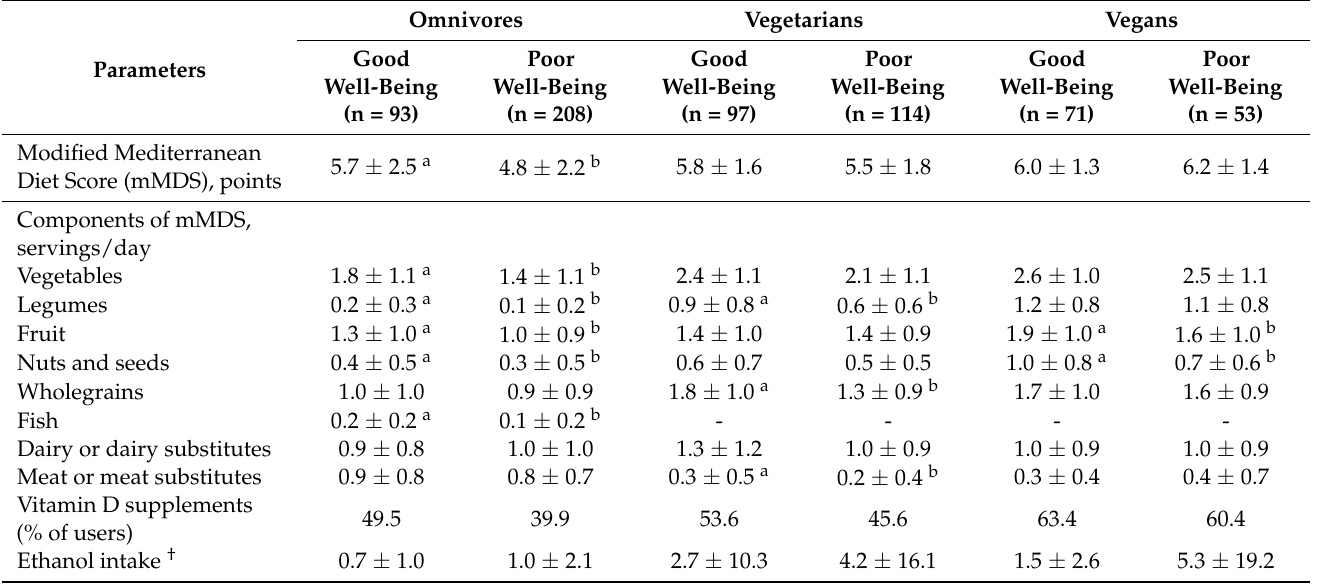
Table 3. Adherence to the Mediterranean-style diet and food consumption by well-being status in omnivores, vegetarians, and vegans (mean ± SD).